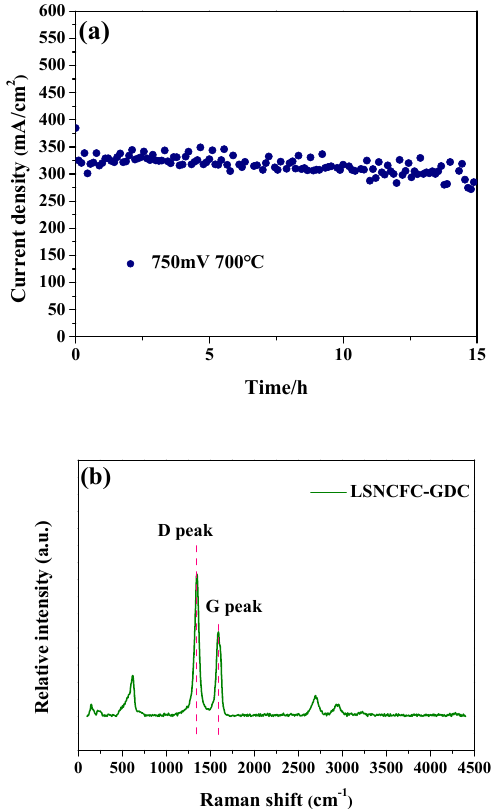
indicates that LSNCFC is a promising fuel reforming material for SOFCs.